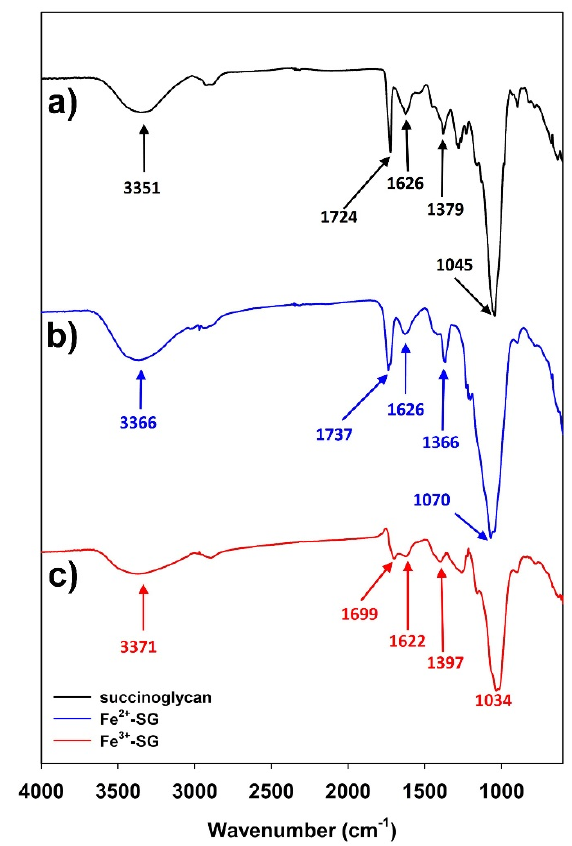
Figure 3. ATR-FTIR spectra of succinoglycan ( a ), Fe 2+ -SG sol ( b ), and Fe 3+ -SG hydrogel ( c ).